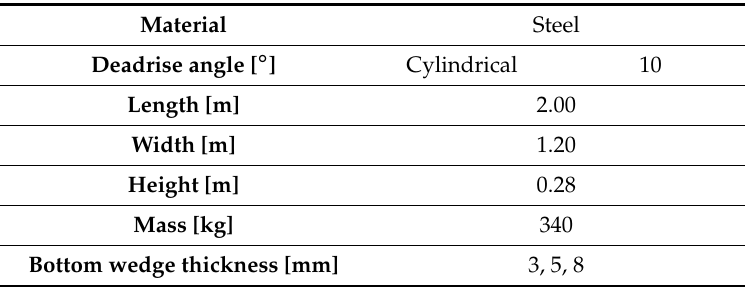
Table 4. Dimensions of the test models.